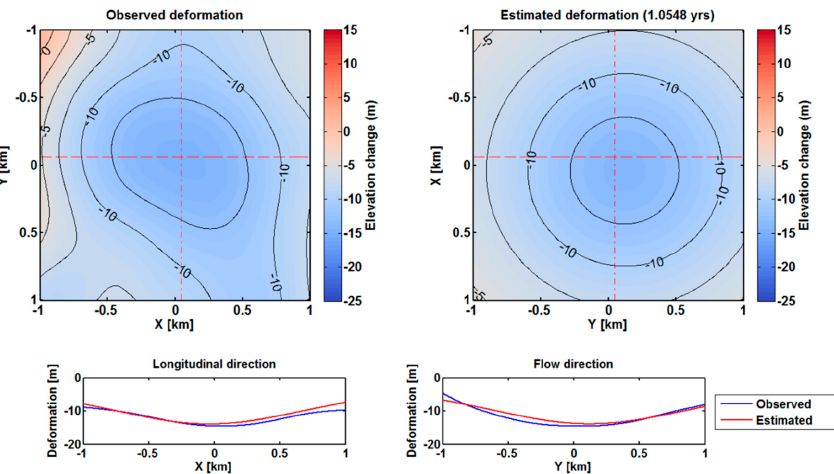
Figure 5. Comparison between the observed and estimated deformation from the modified deformation model after the global optimization process during 2011–2012, with the setting time as the actual elapsed time. The minimum root-mean-square (RMS) difference between the two deformation maps was 1.20 m. Profiles in the longitudinal and along-flow directions are plotted along the red dashed and dot-dashed lines, respectively.